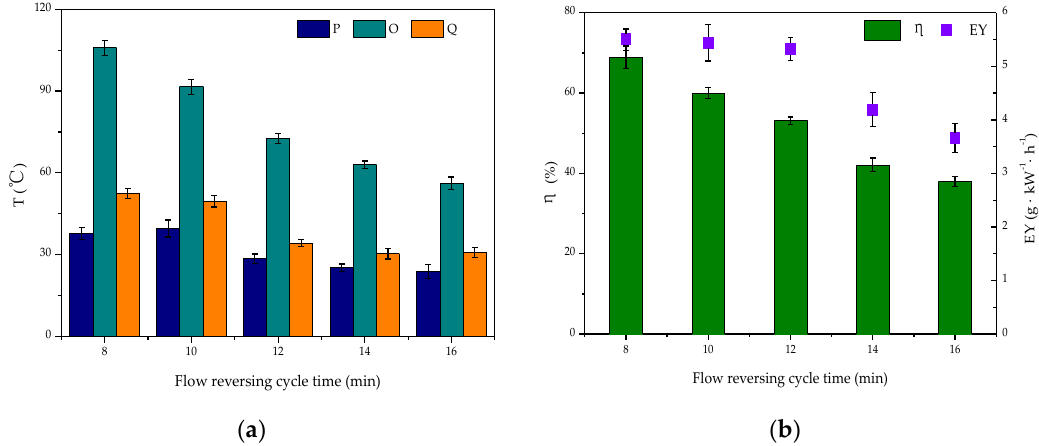
Figure 4. Effect of flow reversing cycle on reverse-flow dielectric barrier discharge (DBD)-catalyst reactor capabilities: ( a ) changes in T; ( b ) changes in η and EY.